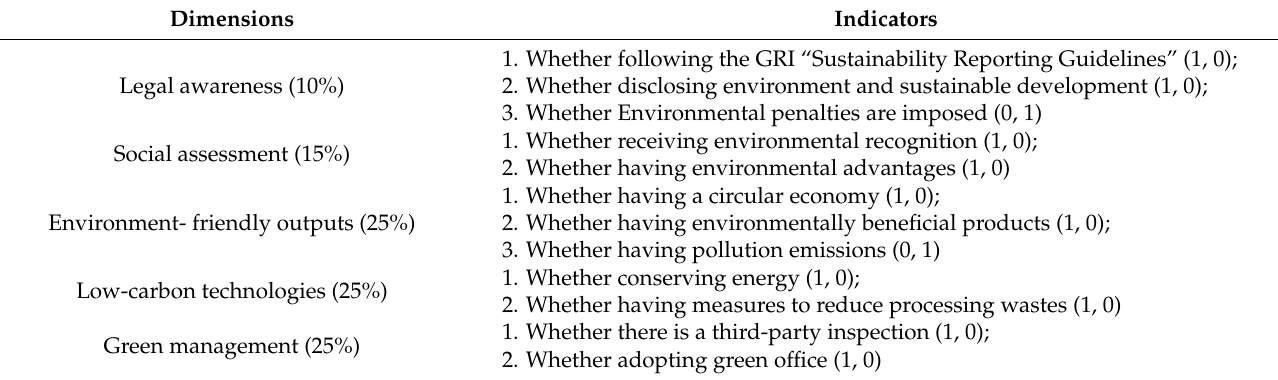
Table 1. Corporate environmental responsibility scoring